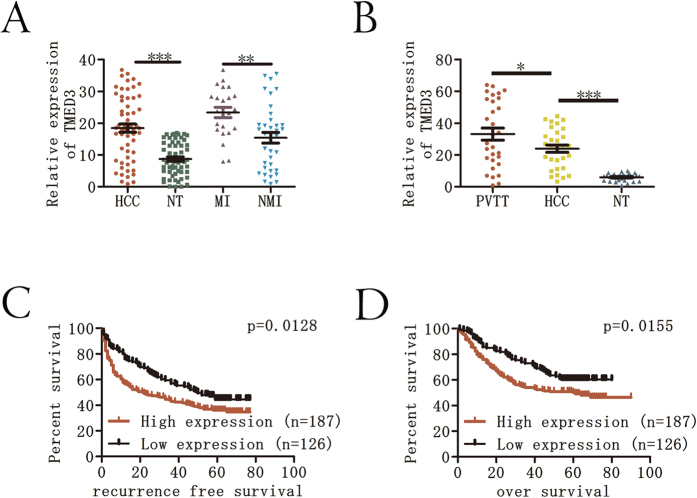
TMED3 expression is up-regulated in HCC and in cases of PVTT.(A) Relative TMED3 mRNA expression levels in 60 cases of HCC, including 25 MI and 35 NMI, were analyzed by RT-PCR and normalized to β-actin. (B) Relative TMED3 mRNA expression levels in 30 cases of HCC with PVTT were analyzed by RT-PCR and normalized to β-actin. (C) The high TMED3 expression group had a shorter RFS than the low TMED3 expression group. (D) The high TMED3 expression group had a shorter OS than the low TMED3 expression group. *p < 0.05, **p < 0.01, ***p < 0.001.